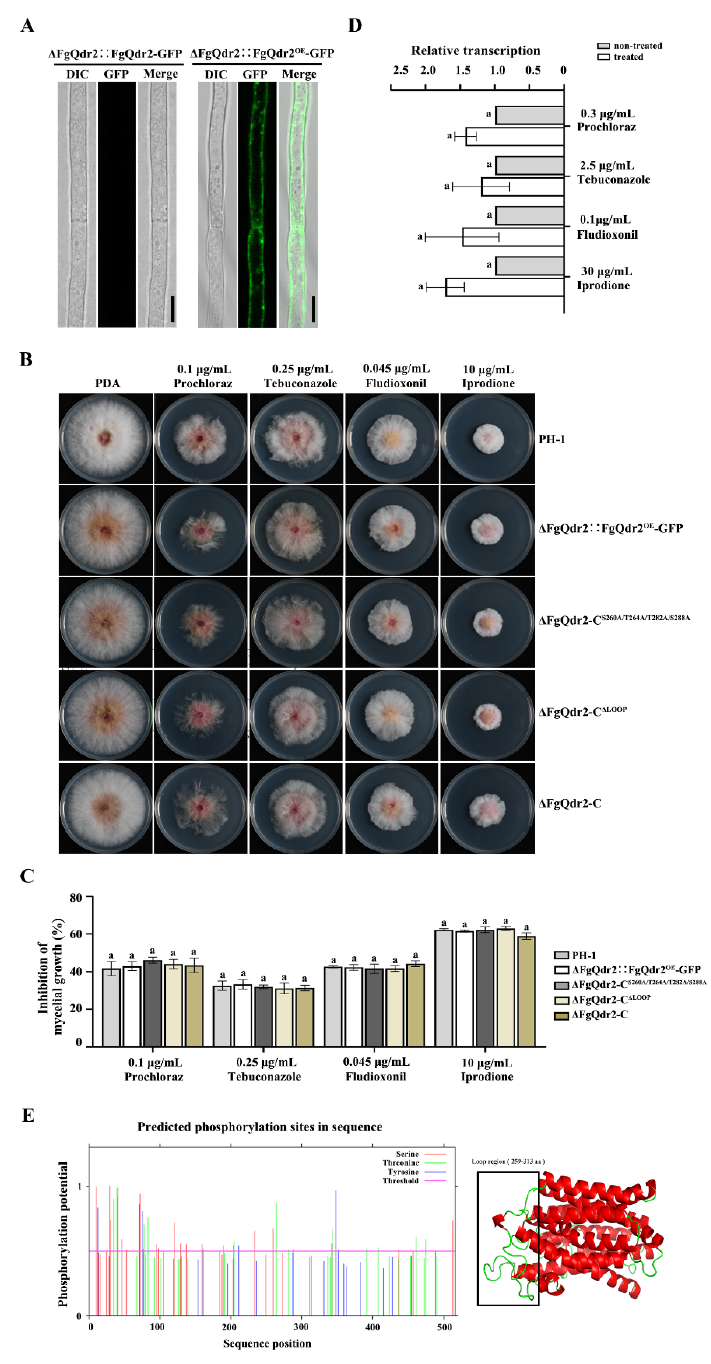
Figure 2. The overexpression, mutation of phosphorylation sites, and deletion of the LOOP region did not alter the regulation of FgQdr2 in drug resistance. ( A ) Overexpressed FgQdr2 is localized along the plasma membrane. Bar = 10 µ m. ( B , C ) Sensitivity of each strain to fungicide stress, colony morphology ( B ) and mycelial growth inhibition ( C ) were photographed and calculated after 3 d incubation at 25 °C, respectively. ( D ) The quantitative reverse transcription PCR (qRT-PCR) re- vealed that the transcription level of FgQDR2 was not upregulated under the above drug treat- ments. The stain was first cultured in yeast extract peptone dextrose (YEPD) for 24 h, then trans- ferred to YEPD supplied with (treated) or without (non-treated) the corresponding fungicide. The FgQDR2 transcription was determined after another 1 h culture. The expression level of FgQDR2 in